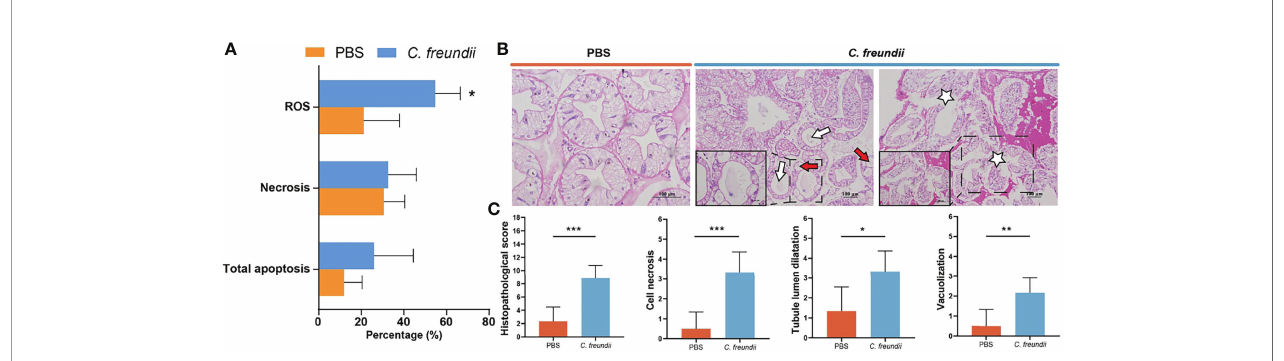
FIGURE 5 | Analysis of damage to the hepatopancreas of cray fi sh. (A) ROS-positive, necrosis and apoptosis rates in hepatopancreatic cells. Results are shown as means ± SD. (B) Histopathological observations on the hepatopancreas of the cray fi sh (H&E staining). The lumen of hepatic tubules is enlarged and the wall of the tubules becomes thin (White arrow); Vacuolar degeneration of tube wall cells (Red arrow); Hepatopancreas cell necrosis (White Pentagram). (C) Intestinal histopathological score. (*:p < 0.05; **:p < 0.01; ***:p